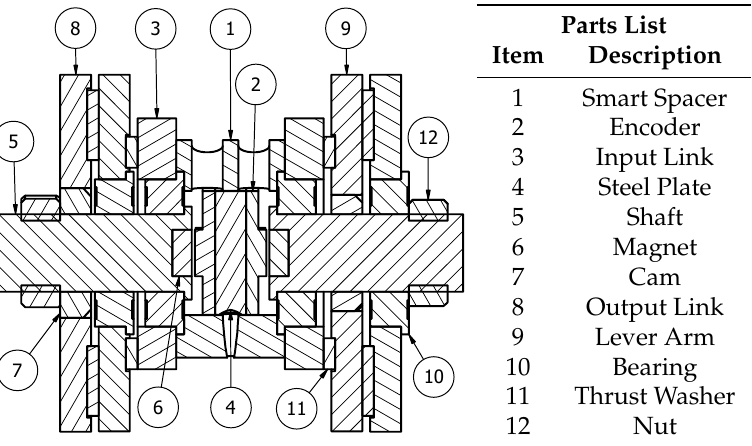
Figure 5. Cross-section view of the SMARCOS presenting the disposition of the encoders. For sake of compactness, the encoders are situated in the heart of the actuator. The rotation joint is split into two axes. On one side the axis is rotating together with the output arm, whereas on the other side, it is attached to the lever